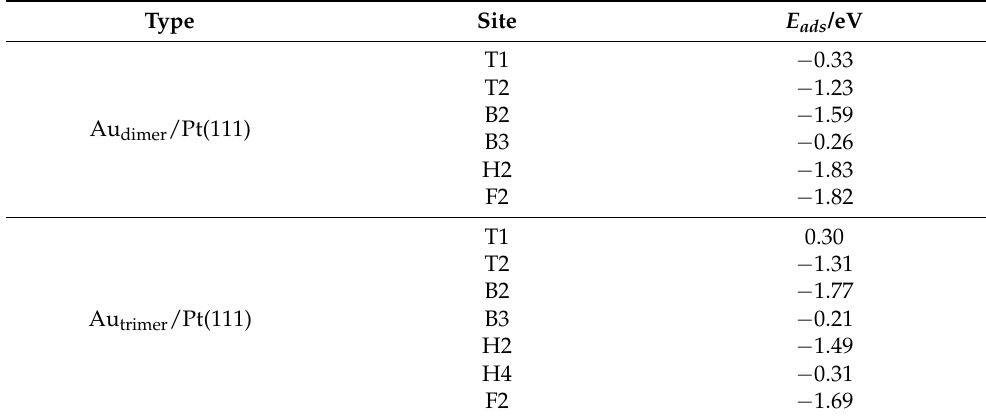
Table 3. Adsorption sites and adsorption energies of NO molecules on Au dimer /Pt(111) and Au trimer /Pt(111) surfaces. Type